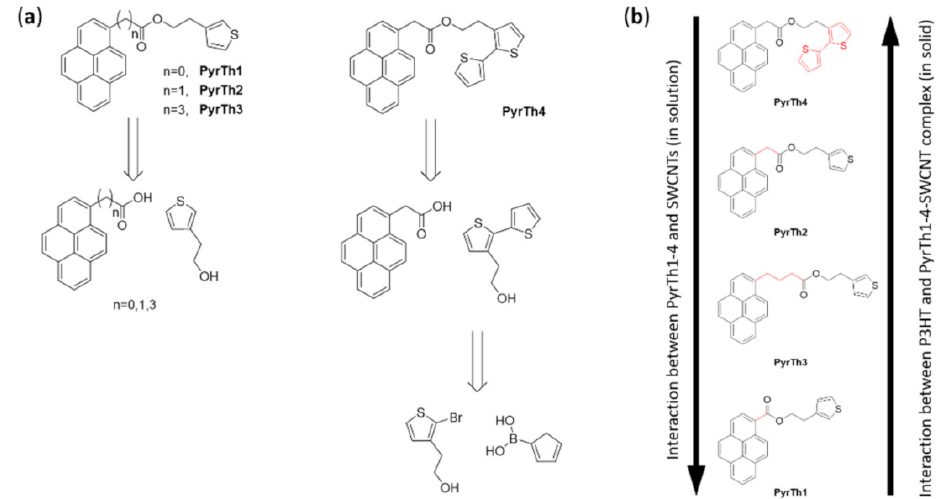
Figure 14. ( a ) Retrosynthetic approach to the preparation of thiophene derivatives with pyrene pendants: esterification of 3-thiopheneethanol (for derivatives PyrTh1–3) and 3-bitiopheneethanol (for derivative PyrTh4 with carboxylic derivatives of pyrene). Reproduced from [92] with the permission of Elsevier. ( b ) Qualitative comparison of the pyrenyl derivatives’ interaction with SWCNTs as observed by fluorescence quenching of pyrenyl derivatives in SWCNT solution and P3HT/pyrenyl-derivatives/SWCNTs thin solid films.